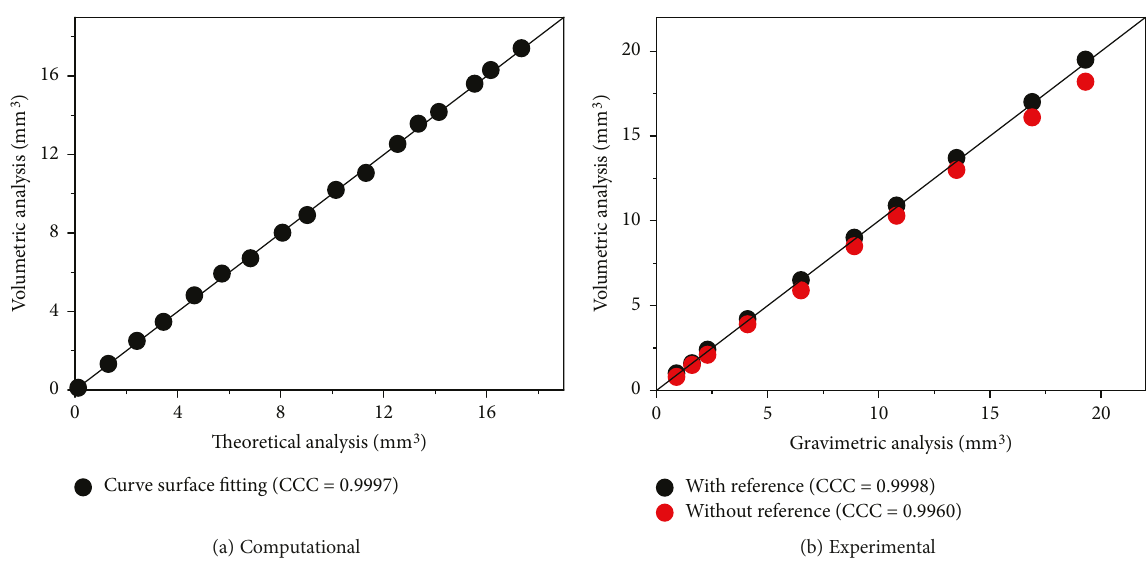
Figure 7: Concordance correlation coe ffi cients results of volumetric assessment methodology based on computational and experimental simulated volume removal